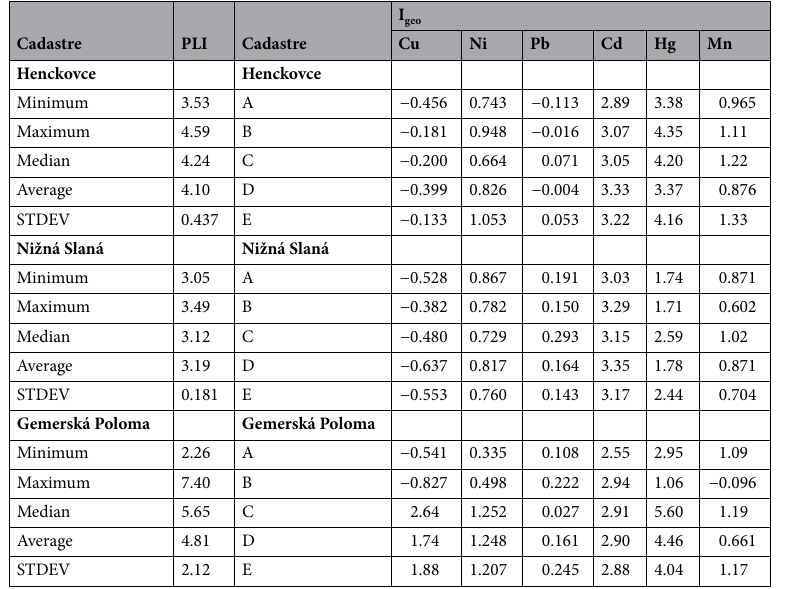
Table 4. Pollution load index (PLI), Geo-accumulation index (I geo